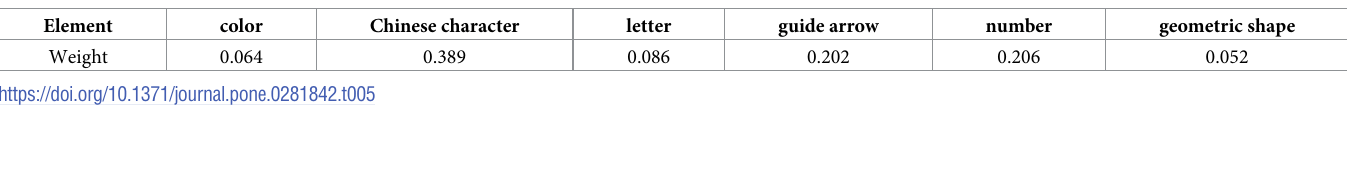
Table 5. Weight of each element of highway exit advance guide sign.